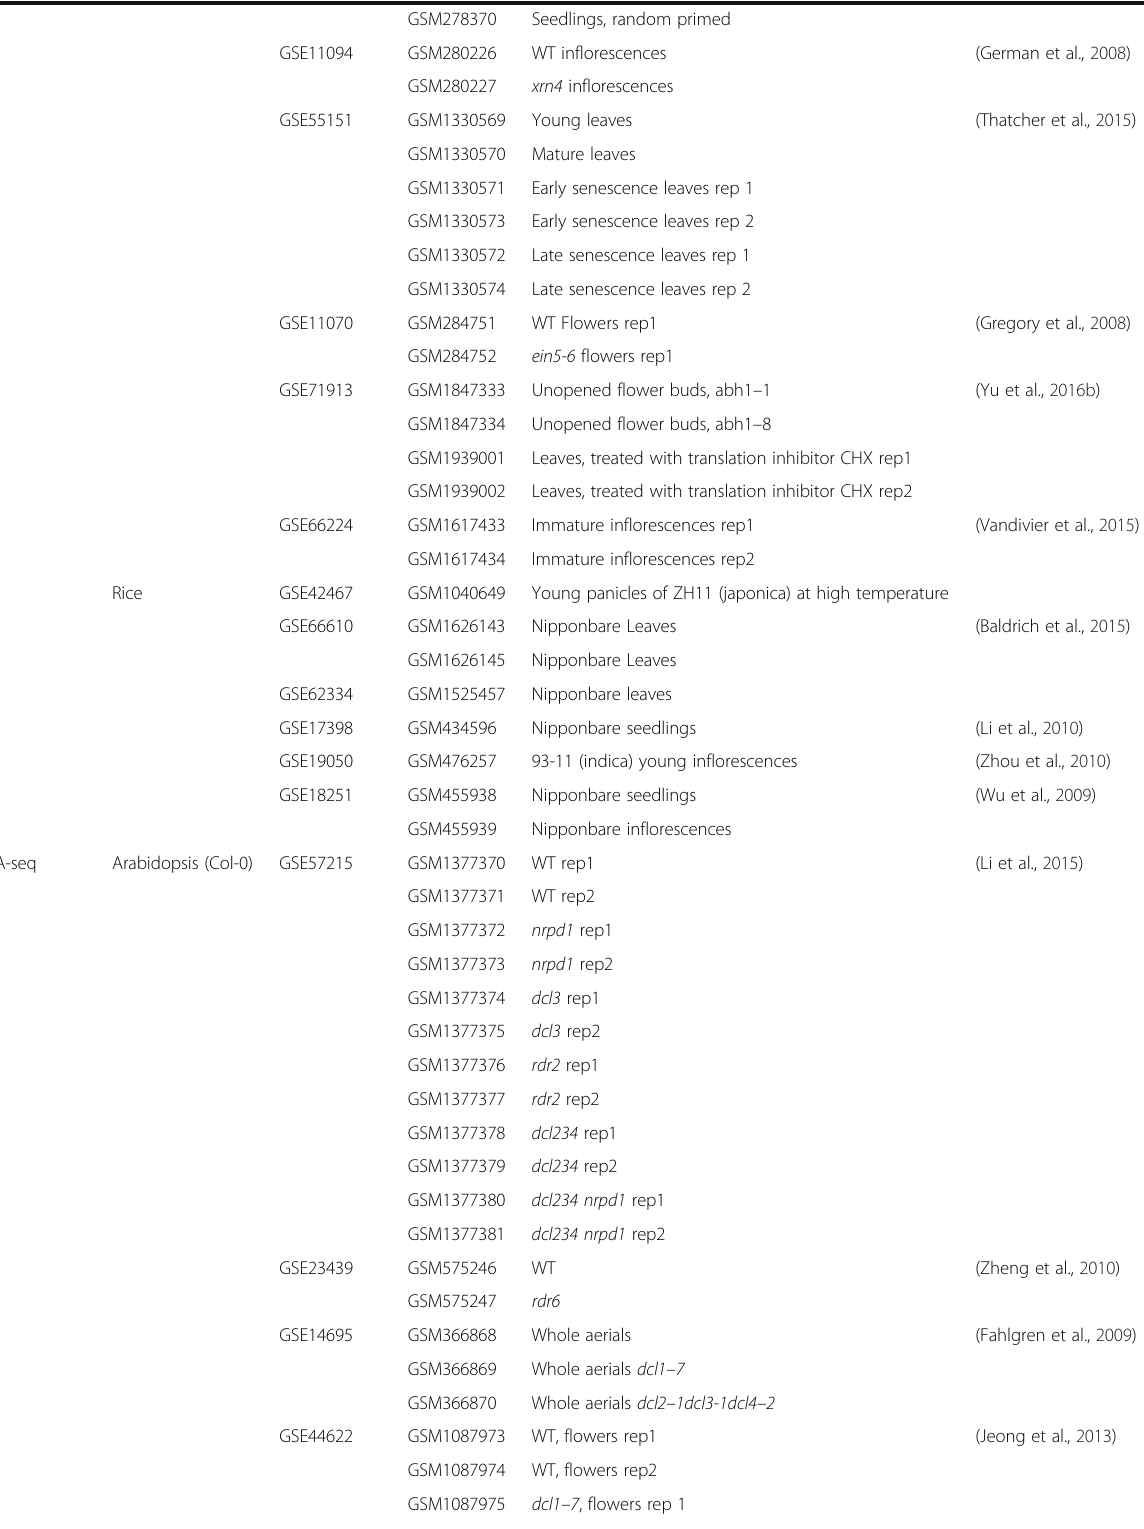
Table 3 List of sequencing data for plant small RNA research